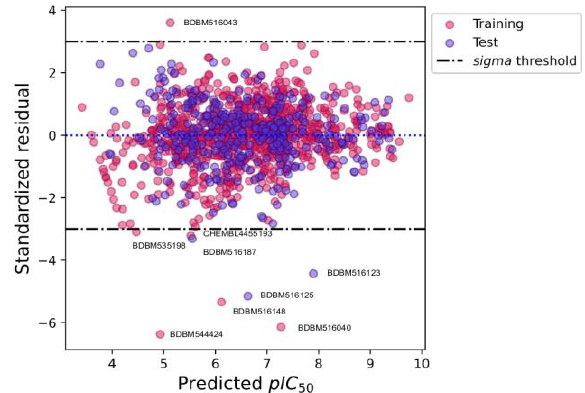
Figure 5. Standardized residual and predicted pIC 50 plot. The pink and purple circles were the training and test datasets, respectively. The black dashed-dotted lines were the standardized residual outlier threshold (±3 standardized residual). Only outlier compounds were annotated in this plot.